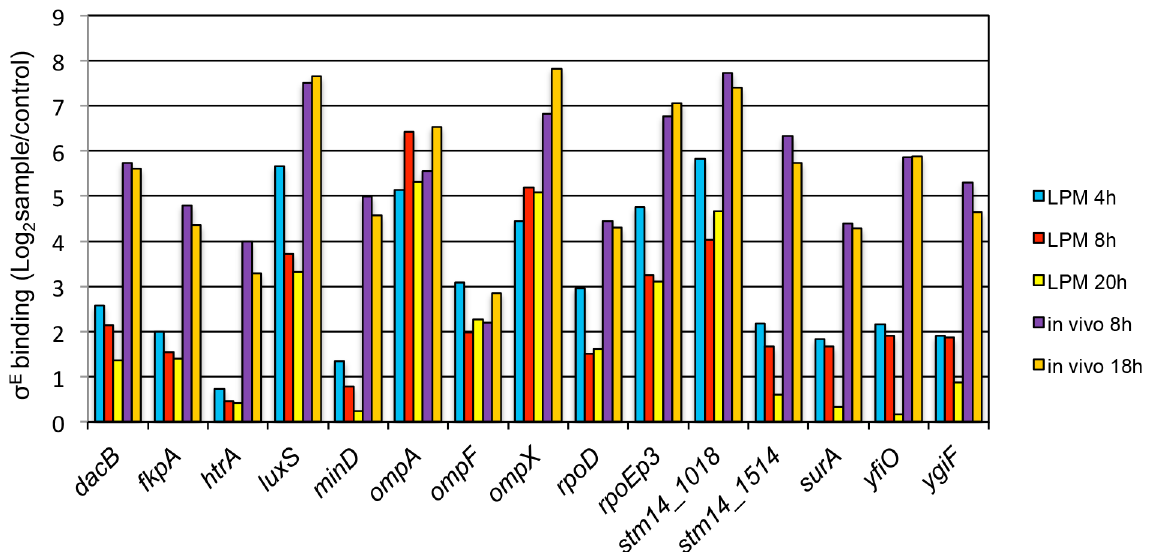
Fig 4. Comparison of σ E -binding sites between in vitro cultured conditions and in vivo infection. WT bacteria were cultured in acidic minimal medium (LPM) for 4 h, 8 h, or 20 h. ChIP and qPCR followed the same procedures as described in Fig 2. The fold enrichment of σ E -binding sites was determined in pulldowns with anti- σ E Ab (sample) versus anti-GFP Ab (control). The in vivo infection results were imported from Fig 2. doi:10.1371/journal.pone.0138466.g004 higher ( greA -RpoE1) or lower ( rpoE -RpoE1 and ompX -RpoE1) susceptibility than WT at 60 min post-challenge. At the 2 h time point, all mutant strains showed significantly altered sensi- tivity to oxidative stress compared to WT (Fig 7B). These results suggested the genes regulated by σ E ( greA , luxS , ompA , and ompX ) were involved in heat shock and oxidative stress response.